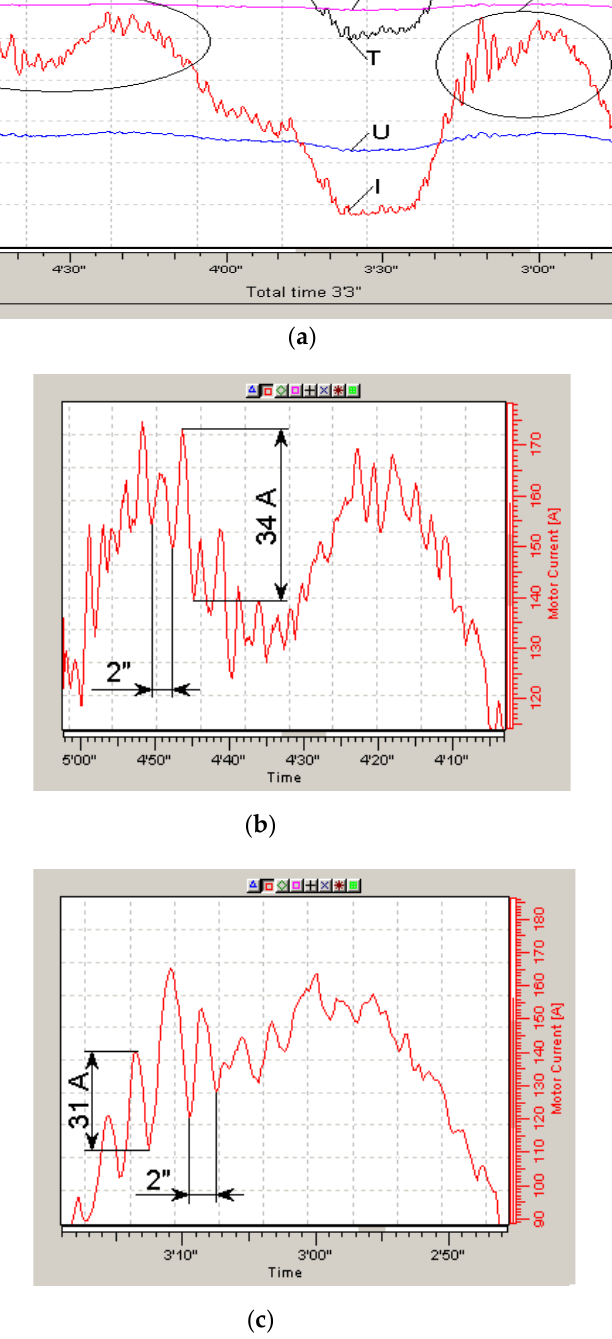
Figure 5. Diagrams of movement at low speed along track 3 with parameters U = 272 V, f = 17 Hz and U/f = 16 Fl ( a ) and extended sections 1 ( b ) and 2 ( c ) of the current diagrams.